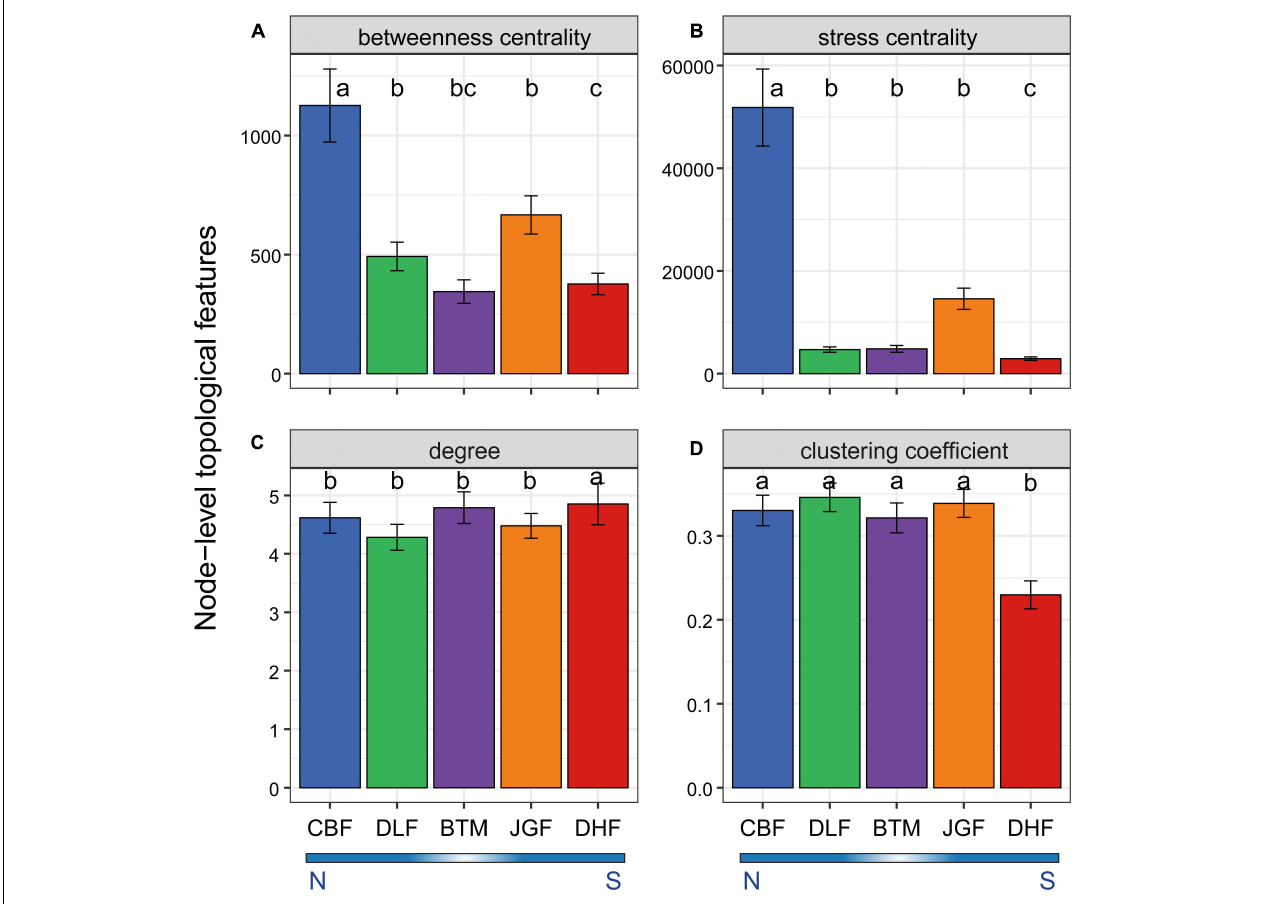
FIGURE 2 | Node-level topological features in the network for the microbial community across latitudinal forest ecosystems. The topological features include betweenness centrality (A) , stress centrality (B) , degree (C) , and clustering coefficient (D) . Data are means ± SE, n , node numbers. Pairwise comparison was performed between latitudinal samples. Different letters (a, b, c) indicate a significant difference ( P < 0.05) by Kruskal–Wallis test. N, northern sites; S, southern